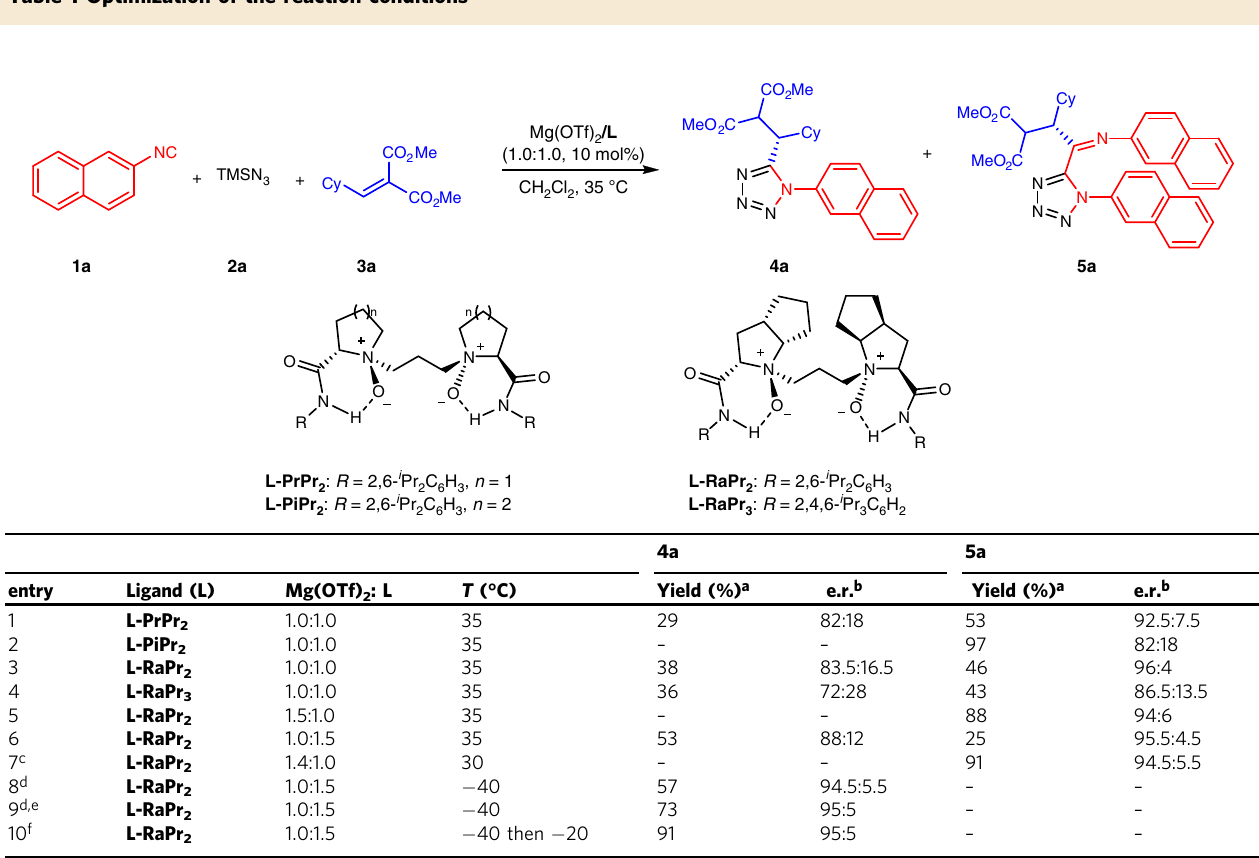
Table 1 Optimization of the reaction